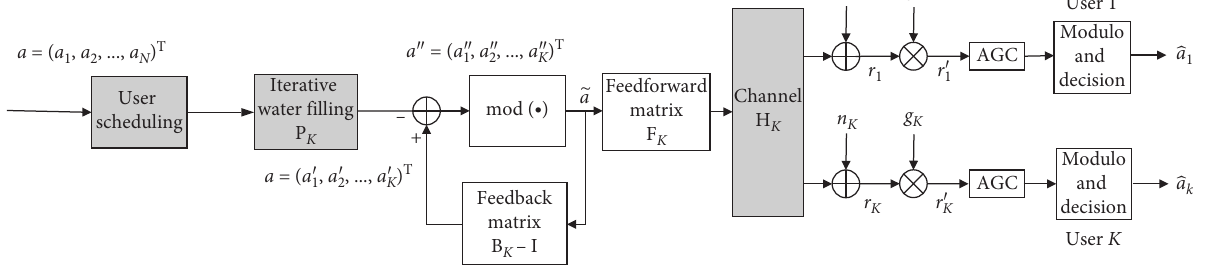
Figure 3: Diagram of improved THP based on the iterative water filling